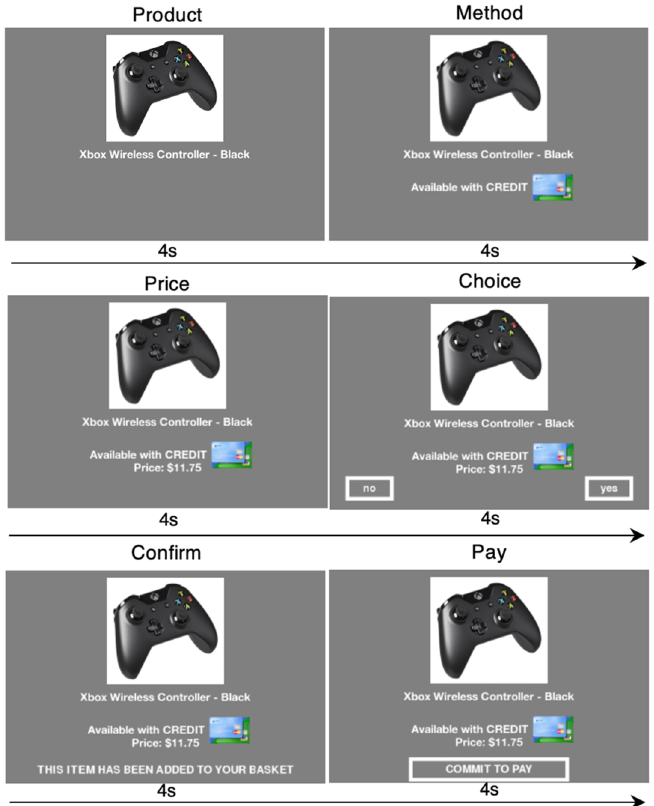
Figure 1. Shopping task trial structure in the current study. Participants viewed the product for 4 s, the payment method for 4 s, the price for 4 s, and then made a choice to purchase within 4 s. Post-decisional periods consisted of a confirmation, 4 s, and a pay response, 4 s. Purchase trial shown; if not purchased, the confirmation indicated “basket unchanged” and the pay screen indicated “no payment necessary.” Intertrial interval